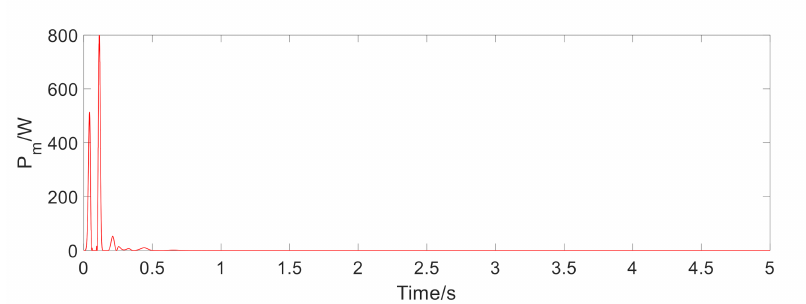
Figure 8. The instantaneous output power of regenerative motor under a smooth pulse.